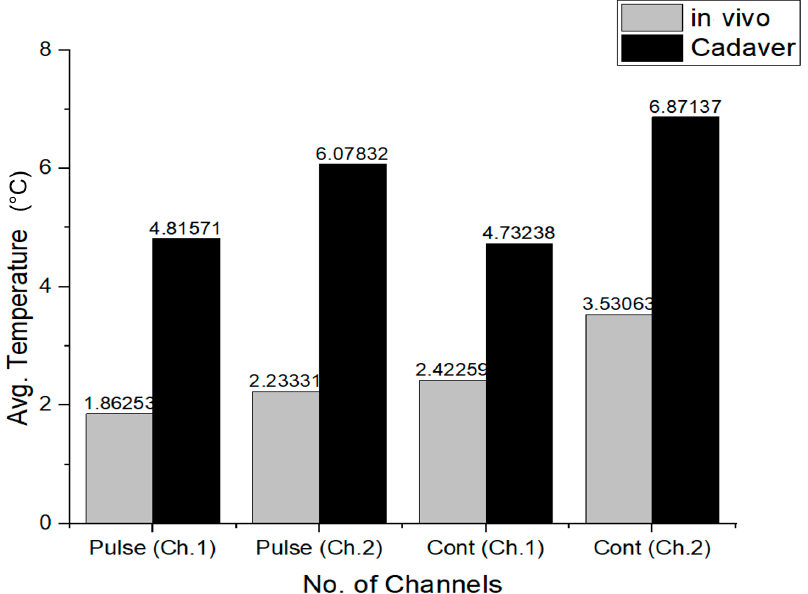
Figure 11. Maximum average temperature changes for in vivo and cadaver measurements at 5 W LVAD under pulsed and continuous transmission protocols (channel 1 and channel 2).